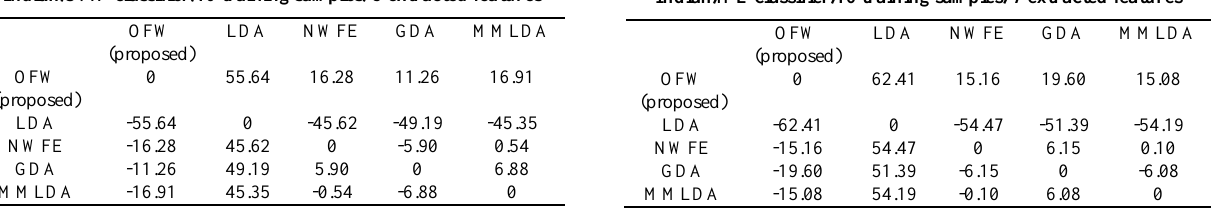
Table 5. McNemars test results ( 𝒁 𝒓𝒄 denotes each case of table where 𝒓 is the row and 𝒄 is the